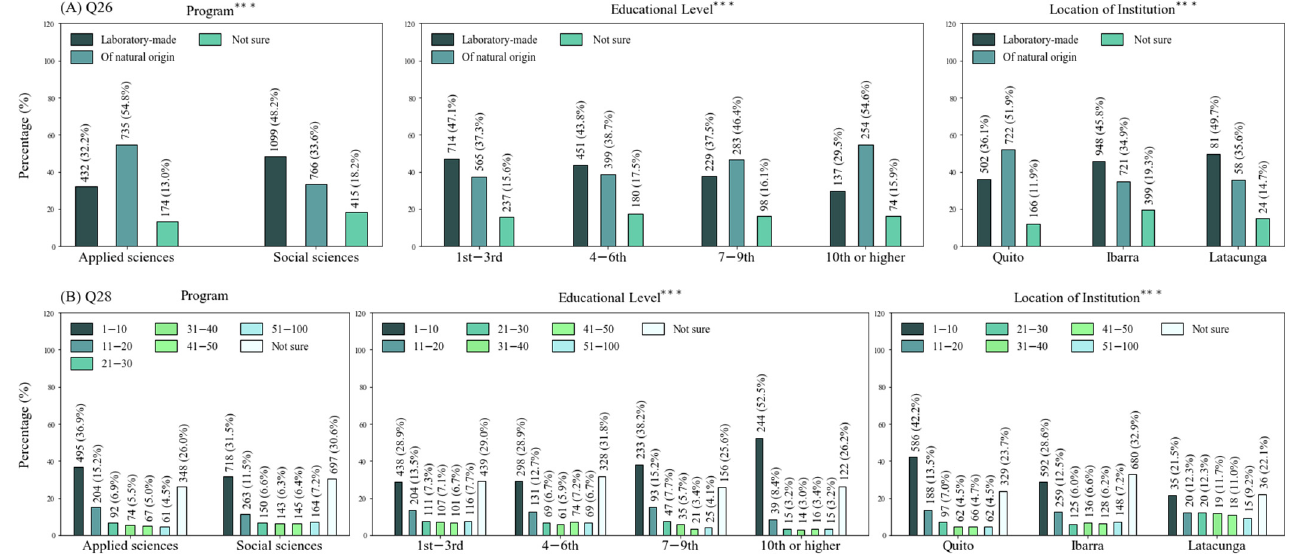
Figure 3. Percentages of multiple-option questions answered correctly by less than half of the population. ( A ) Question 26; ( B ) Question 28. *** Chi-square values significant at p < 0.001.